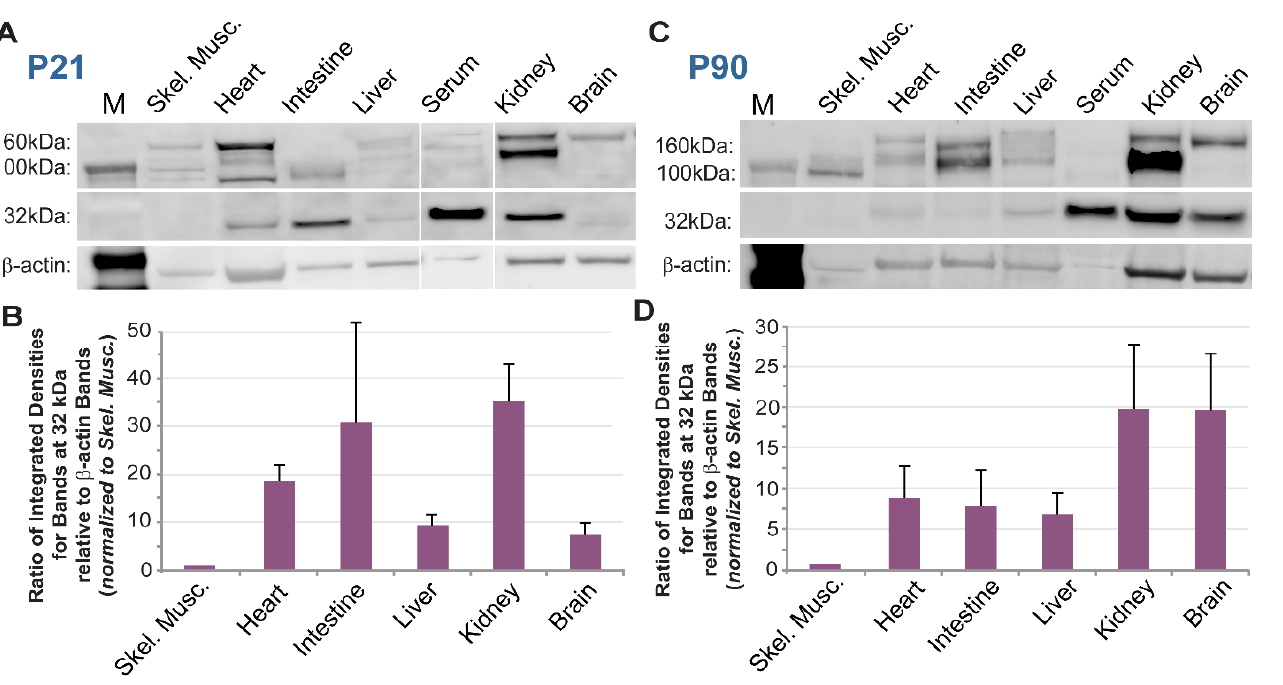
Figure 1. A Truncated Isoform of PDGFR β was Detected alongside Full-Length Receptors across a Range of Murine Tissues at Different Ages. ( A ) Representative images of a Western blot for proteins from select murine tissues at postnatal day 21 (P21) (from n = 3 biological replicates, both sexes) detected by immunolabeling for PDGFR β and β -actin–lane 1: molecular size marker (M), lane 2: skeletal muscle (Skel. Musc.), lane 3: heart, lane 4: intestine, lane 5: liver, lane 6: blood serum, lane 7: kidney, lane 8: brain. ( B ) Graph of the ratio of integrated densities for bands at the 32 kDa size range relative to β -actin bands for each tissue indicated, all of which were normalized to the skeletal muscle samples. Bars are averages with standard deviations. ( C ) Representative images of a Western blot for proteins from select murine tissues at postnatal day 90 (P90) (from n = 3 biological replicate, both sexes) detected by immunolabeling for PDGFR β and β -actin–lane 1: molecular size marker (M), lane 2: skeletal muscle (Skel. Musc.), lane 3: heart, lane 4: intestine, lane 5: liver, lane 6: blood serum, lane 7: kidney, lane 8: brain. ( D ) Graph of the ratio of integrated densities for bands at the 32 kDa size range relative to β -actin bands for each tissue indicated, all of which were normalized to the skeletal muscle samples. Bars are averages with standard deviations.